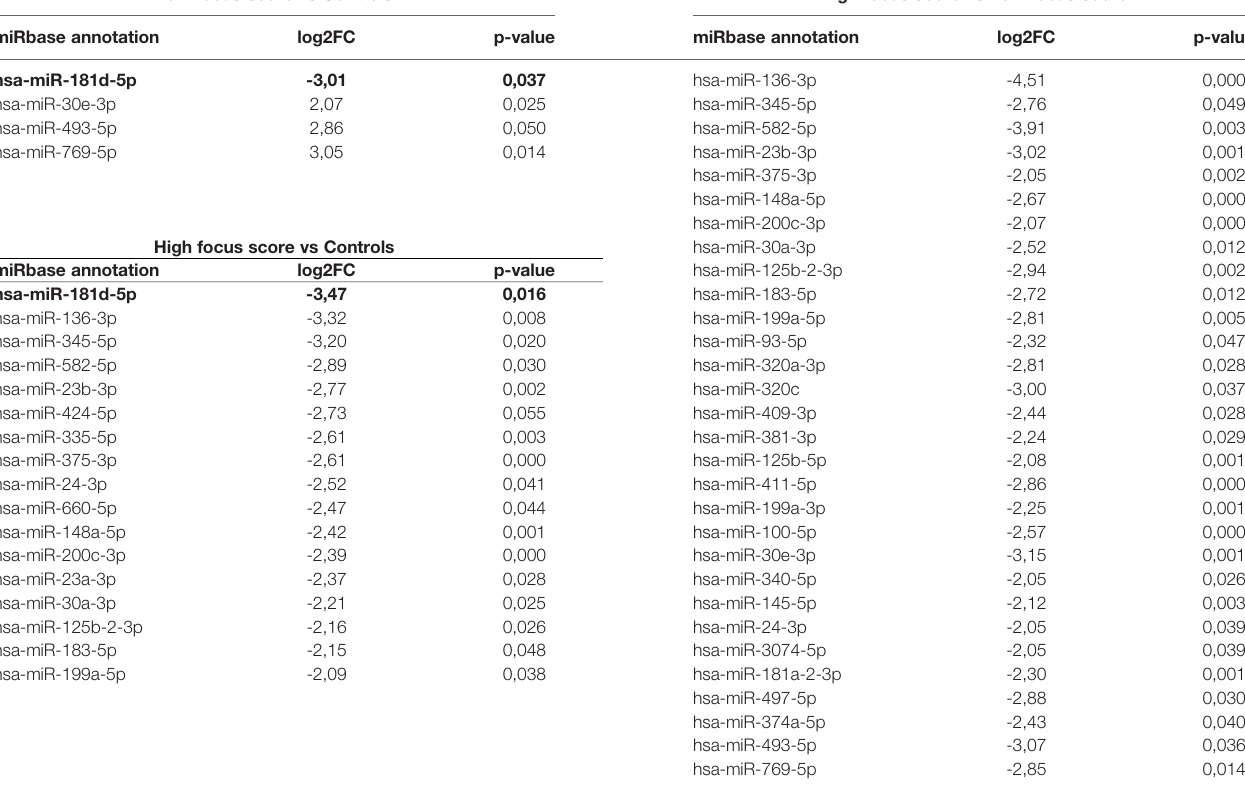
FC, folding change; FS, focus score. The top differentially expressed miRNA found in SS-patients compared to sicca controls is highligted with bold Table S6 ). To test whether molecular functions or biological processes were associated with the hsa-miR-181d-5p, we performed a Gene ontology (GO) analysis. From the total number of target genes predicted to be regulated by hsa-miR- 181d-5p, 14 genes are involved in the response to ER stress, previously reported to be overexpressed in LSG from SS-patients (60) ( Table 3 ). Among them, SEL1L encodes for a protein involved in ubiquitin protein ligase binding and DERL1 for a protein that retrotranslocates misfolded or unfolded proteins from the ER lumen to the cytosol for proteasomal degradation. Both represent key components of the ERAD machinery, which